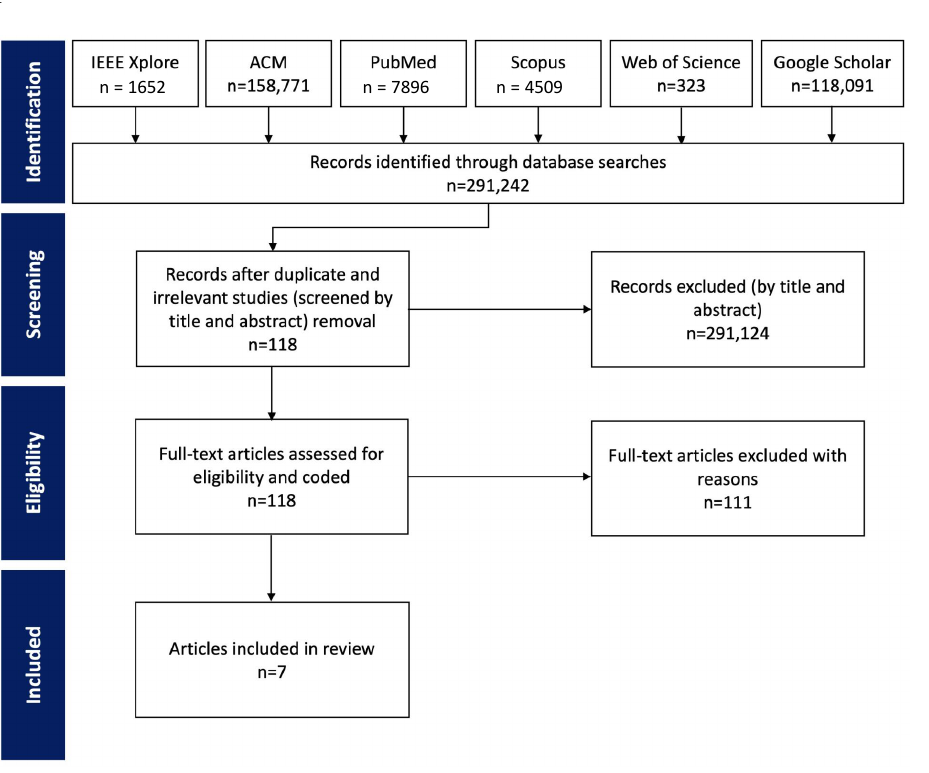
Figure 1. PRISMA flow diagram of the article identification and selection